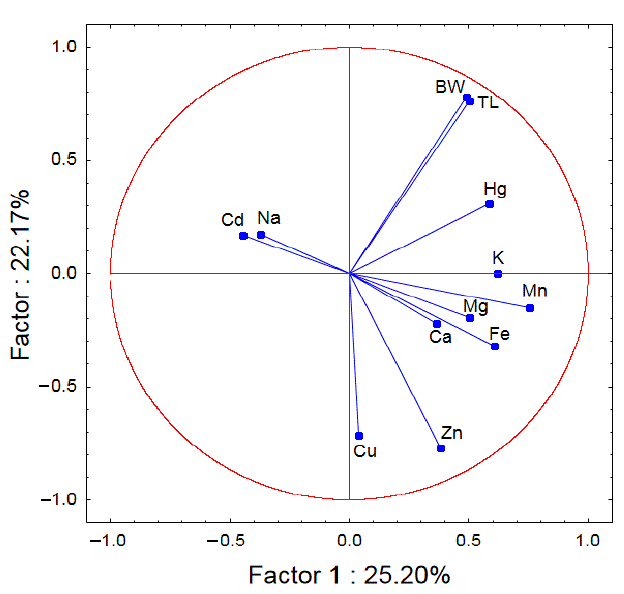
Figure 3. Principal component analysis (PCA) plot (2D) of the relationships between all variables (elements, total body length (LT), and body weight (BW)) in the European eel ( Anguilla anguilla L.). Significant positive correlation coefficients were found between metal pairs in muscles of the fish examined (Fe-Mn, Fe-Cu and Zn-Cu), whereas a significant negative correlation was observed between a pair of Mn-Cd ( p < 0.05) (Table